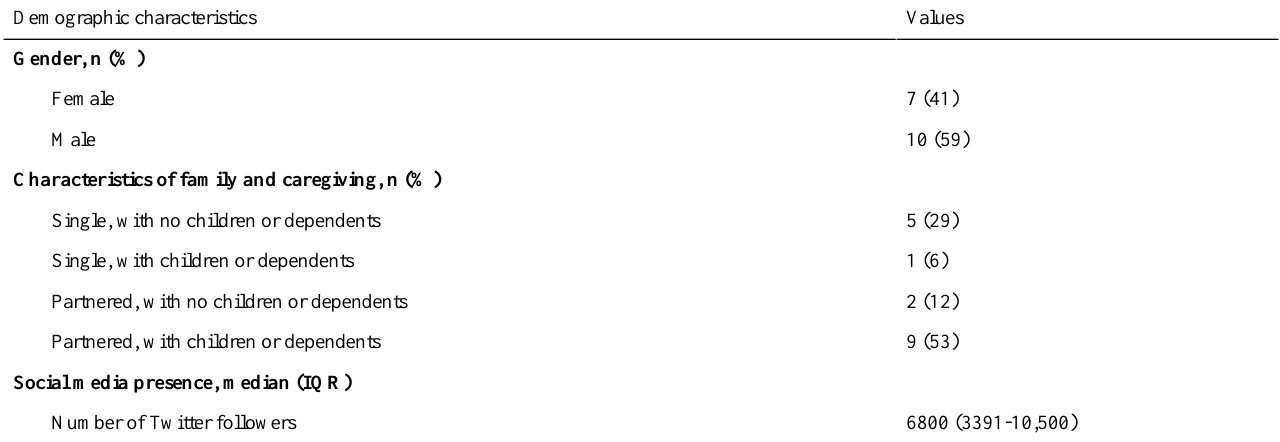
Table 1. Participants’demographics.